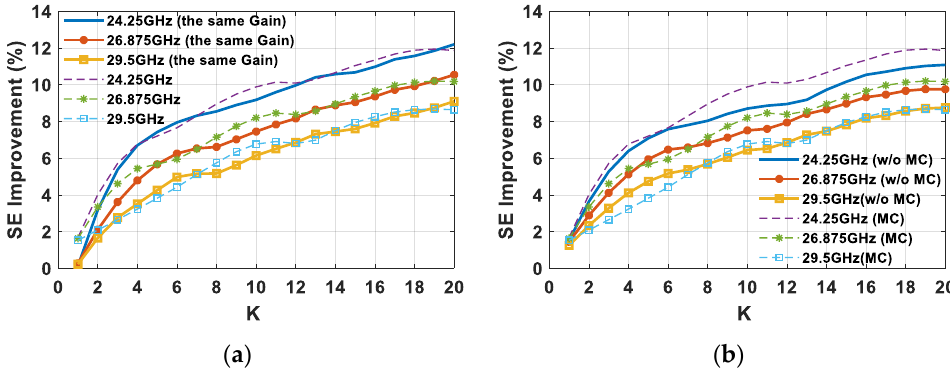
Figure 19. Percentage SE improvement as a function of the number of users ( K ) between square and triangular lattice planar arrays composed of 64 elements in the event of ( a ) the same HAPS array gain for all of the frequencies for both lattices; and ( b ) an ideal planar array equipped with 64 elements without MC (w/o MC).